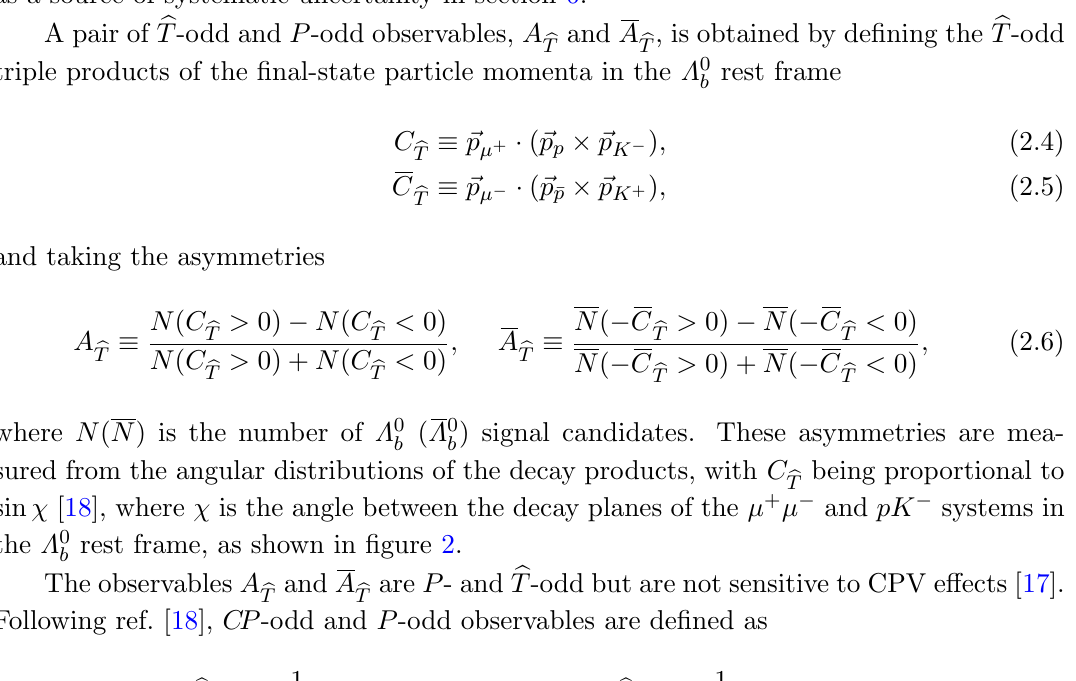
pK (cid:0) (cid:22) + (cid:22) (cid:0) decays, in the (cid:3) 0 b !